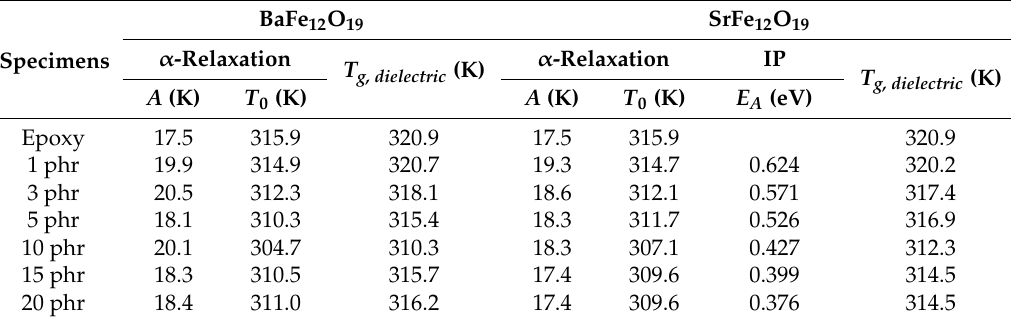
Table 1. Specimens’ composition in phr, activation energy values and parameters derived via fitting data with Equations (2) and (3), for all studied systems and glass transition temperature as determined via BDS.